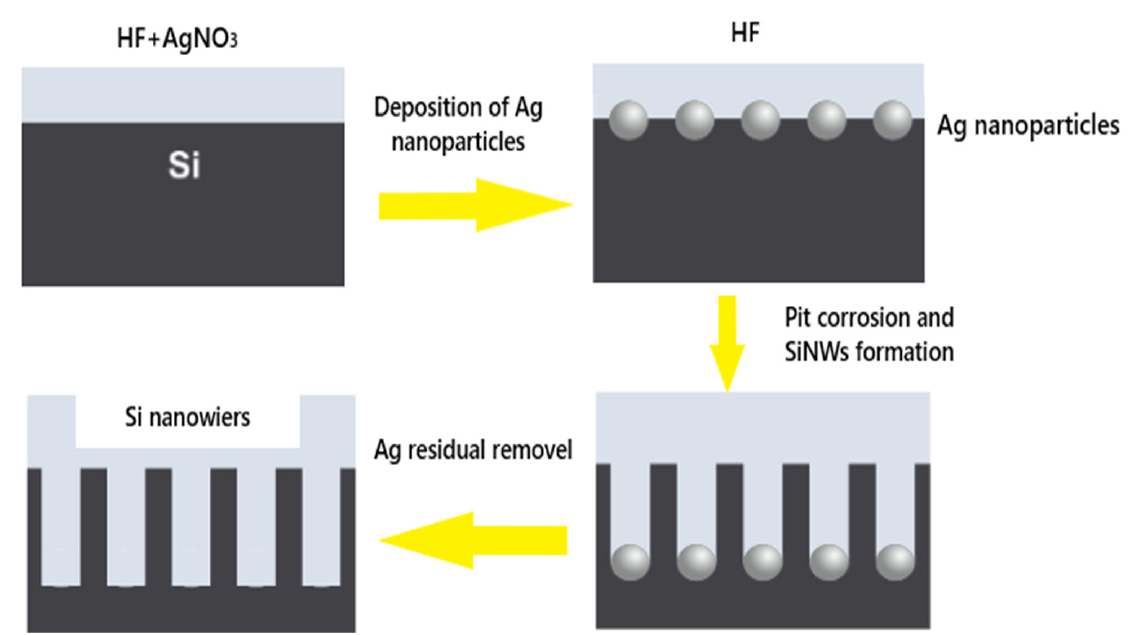
Figure 1. Scheme of the Ag-ACE experimental set-up.